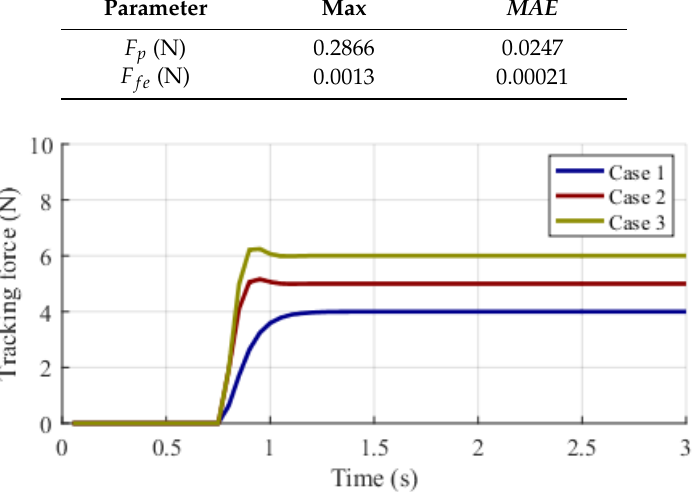
Figure 8. The force monitoring of some cases in simulation testing. Table 2. The quality parameters on the testing data of simulation.